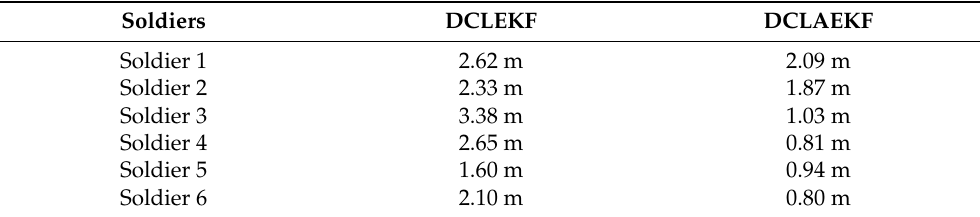
Figure 9. Reference track diagram in the forest environment. Table 3. Localization MSEs of soldiers using different algorithms in a forest environment experiment.